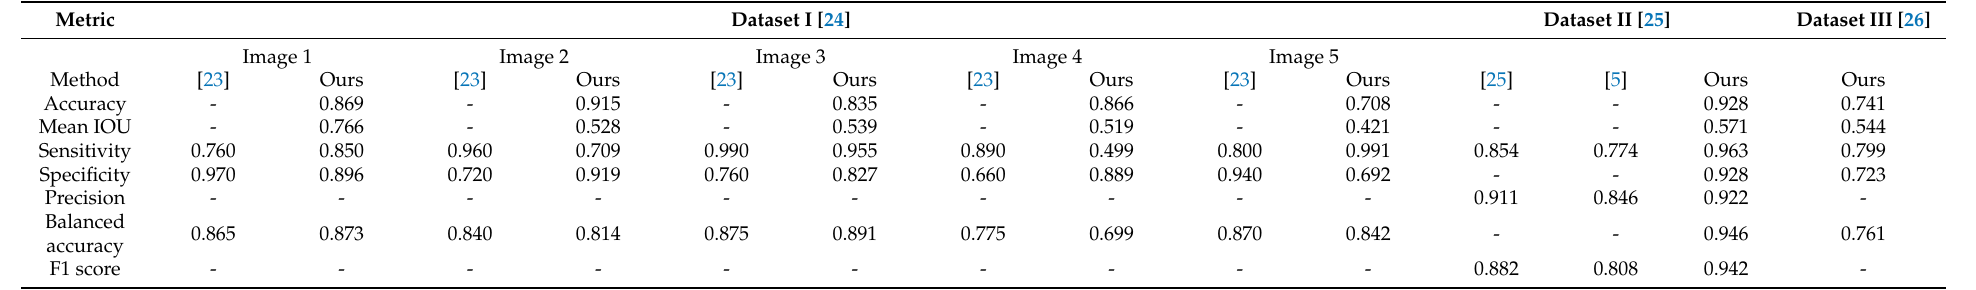
Table 2. The performance comparison (defect detection in whole image) of various defect detection approaches using all three datasets. In this table, - indicates that there is no result available in the reference